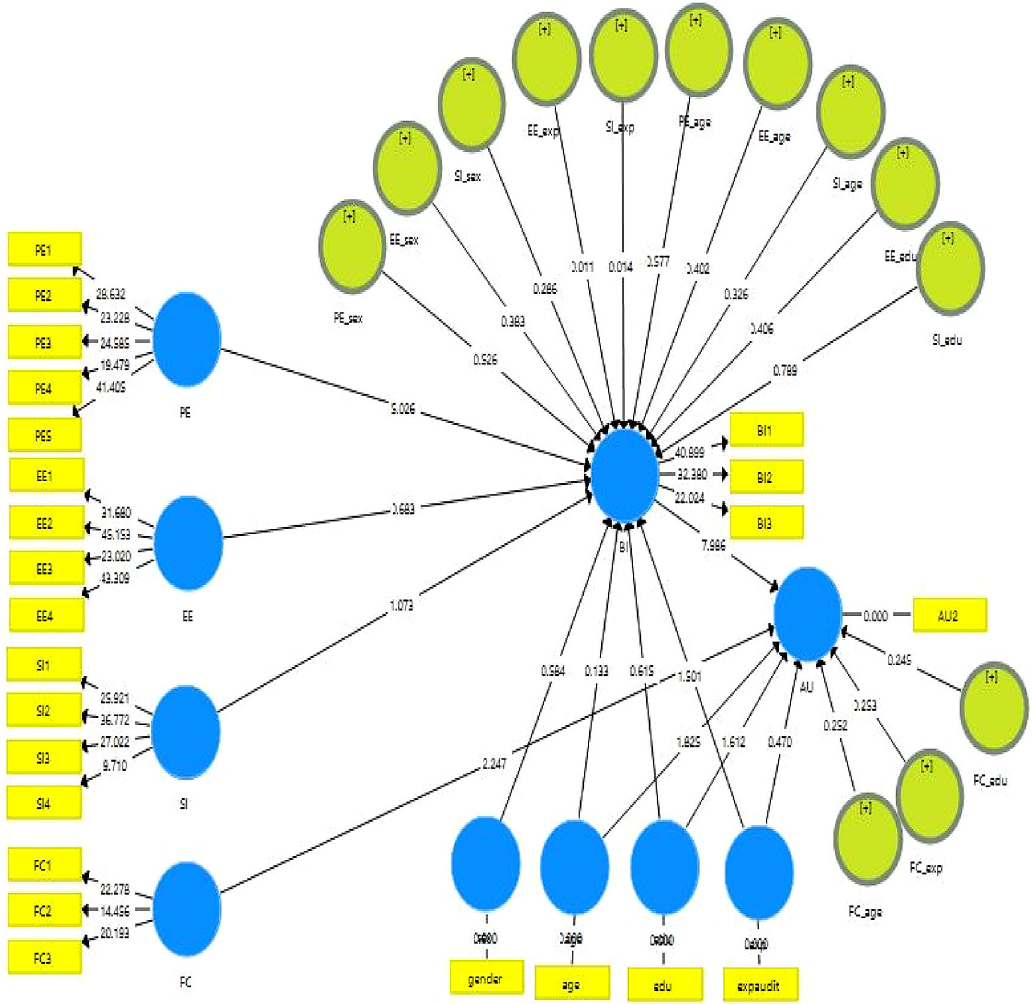
Figure 2. Research structural model. (Source: the results of the author ’ s analysis using the SmartPLS